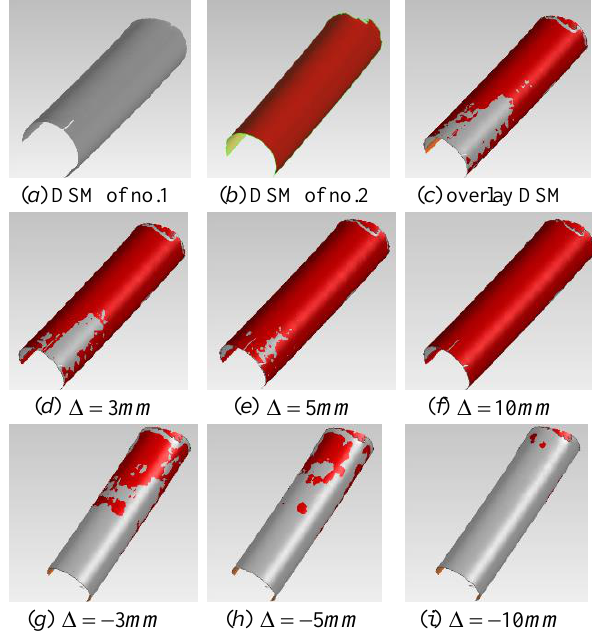
Fig.10 Analysis of tunnel deformation Fig. 10 ( d ) in the gray area and Fig. 10 ( g ) in the red area suggest this region of tunnel’s variable is more than 3 mm ; Fig. 10 ( e ) in the gray area and Fig. 10 ( h ) in the red area suggest this region of tunnel’s variable is more than 5 mm ; Fig. 10 ( f ), ( I ) shows that the tunnel deformation is less than 10 mm